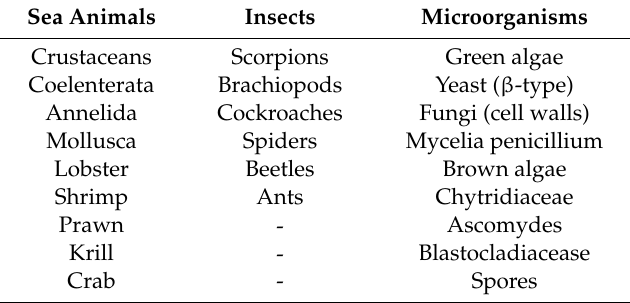
Table 1. Sources of chitin and